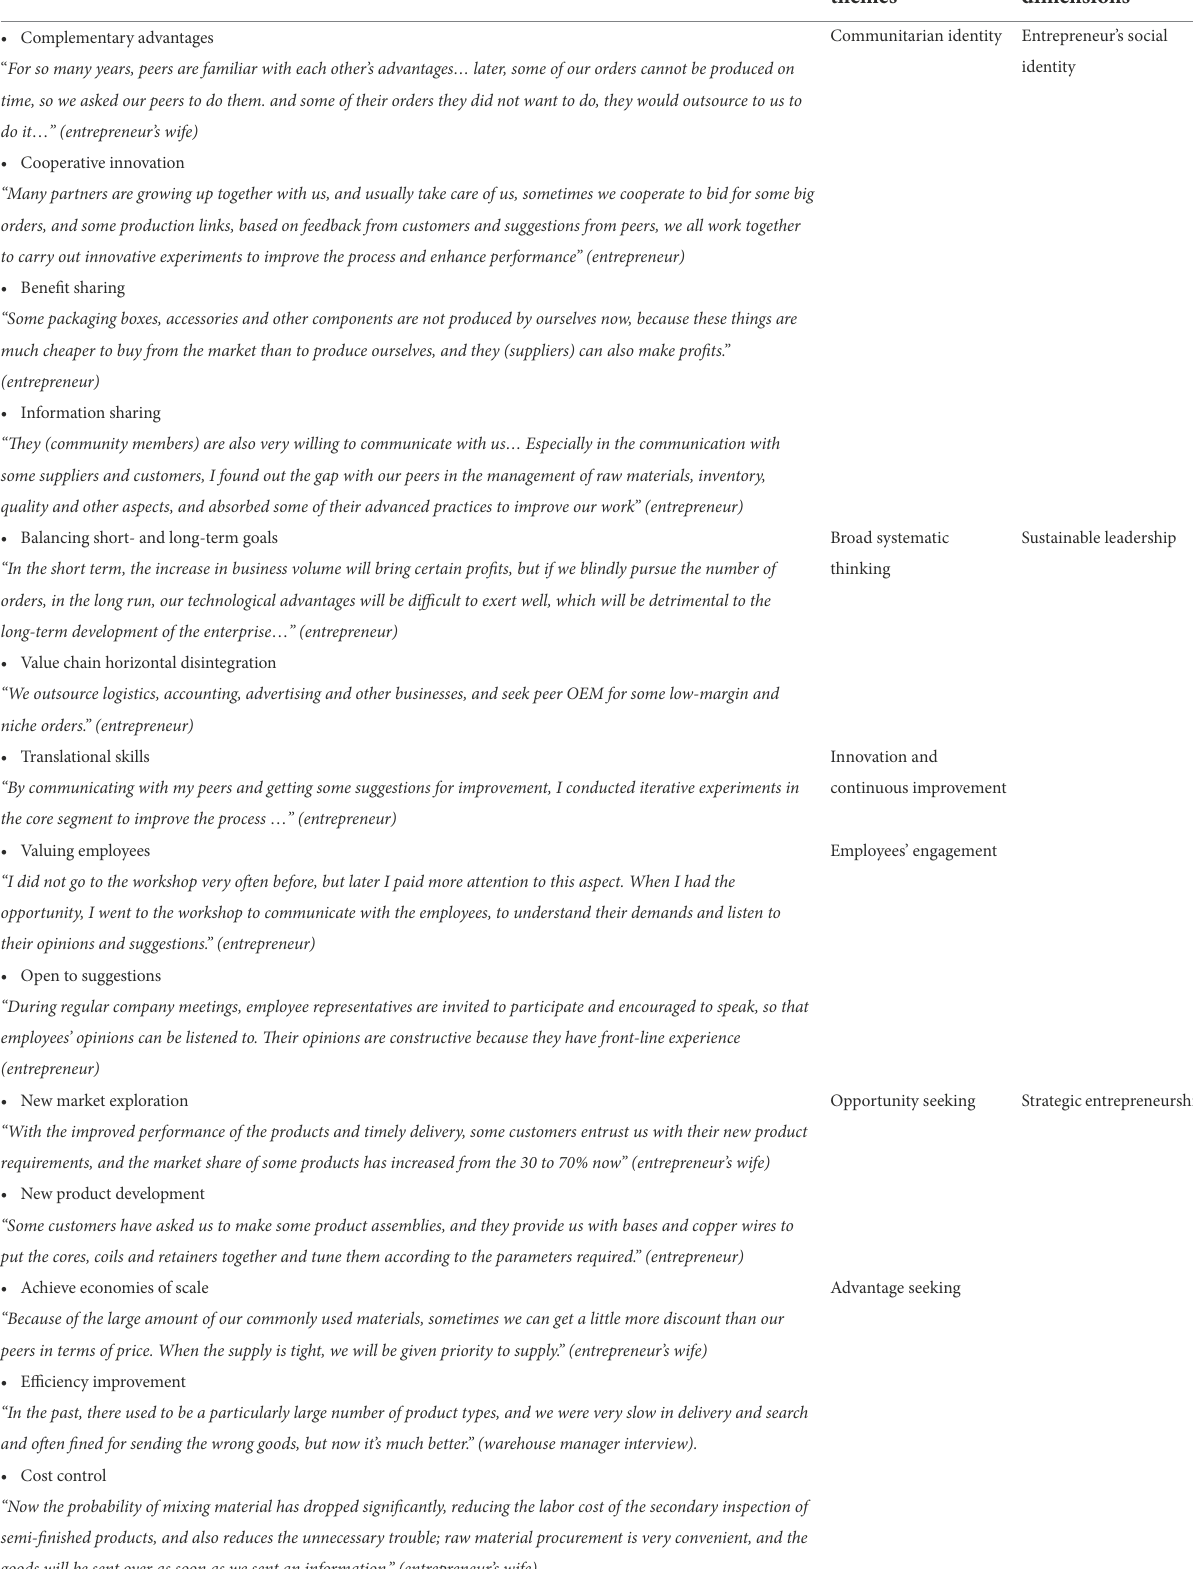
TABLE 5 Typical examples and coding results for the growth stage